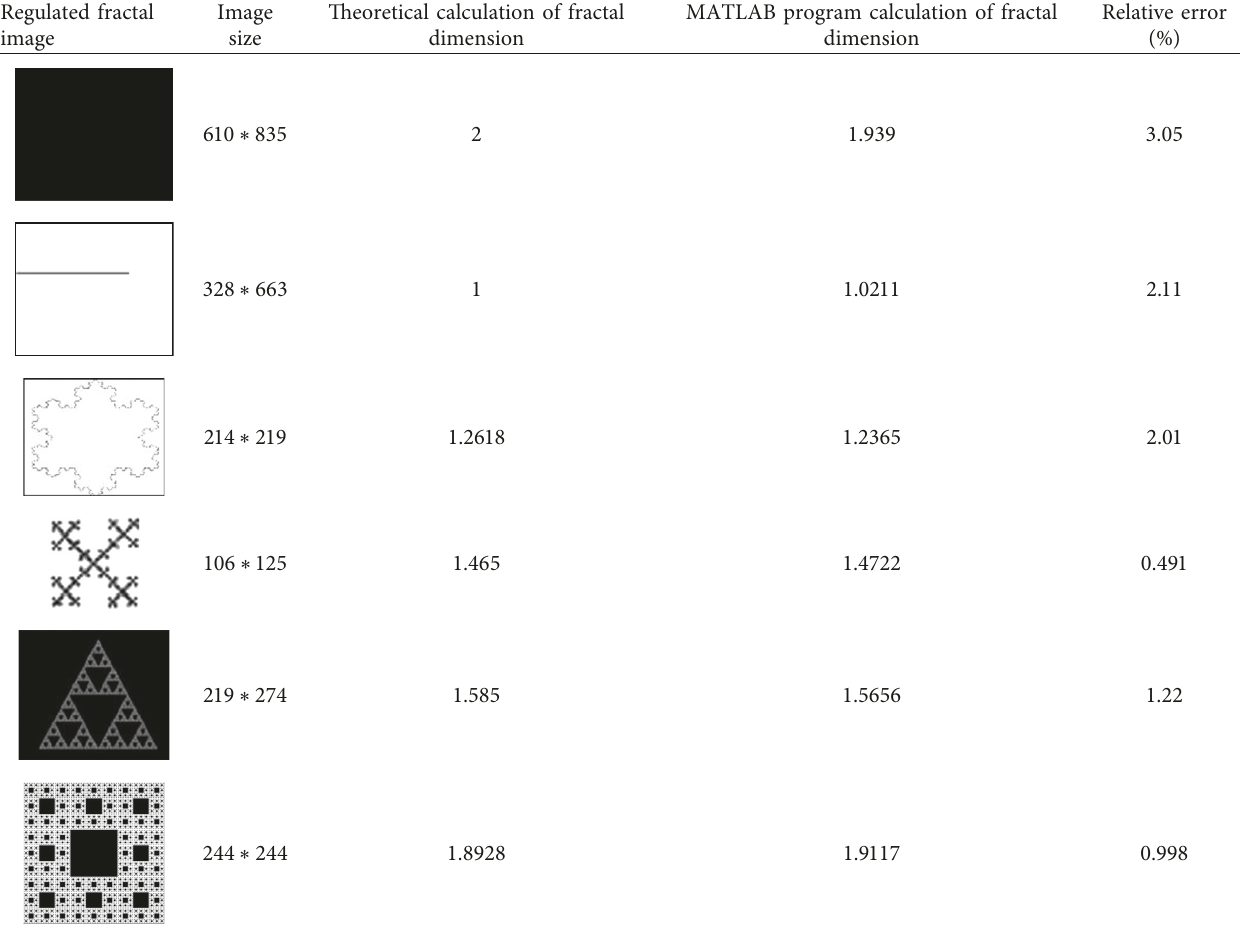
Table 3: Comparison of calculated value and theoretical value of the fractal image based on MATLAB.